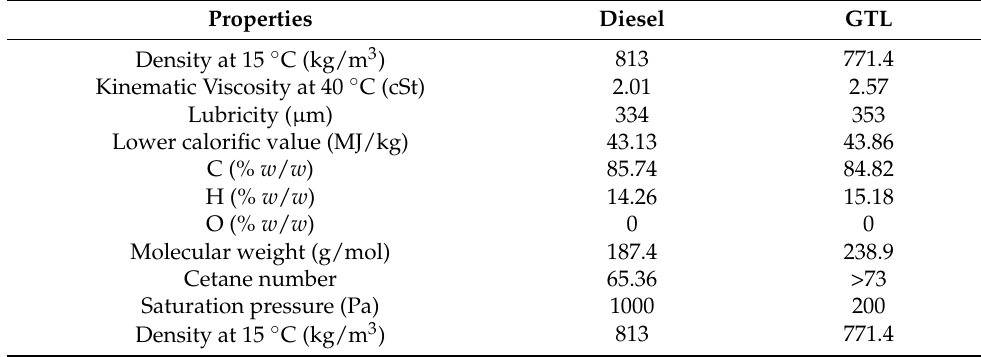
Table 1. Tested fuel properties [31].